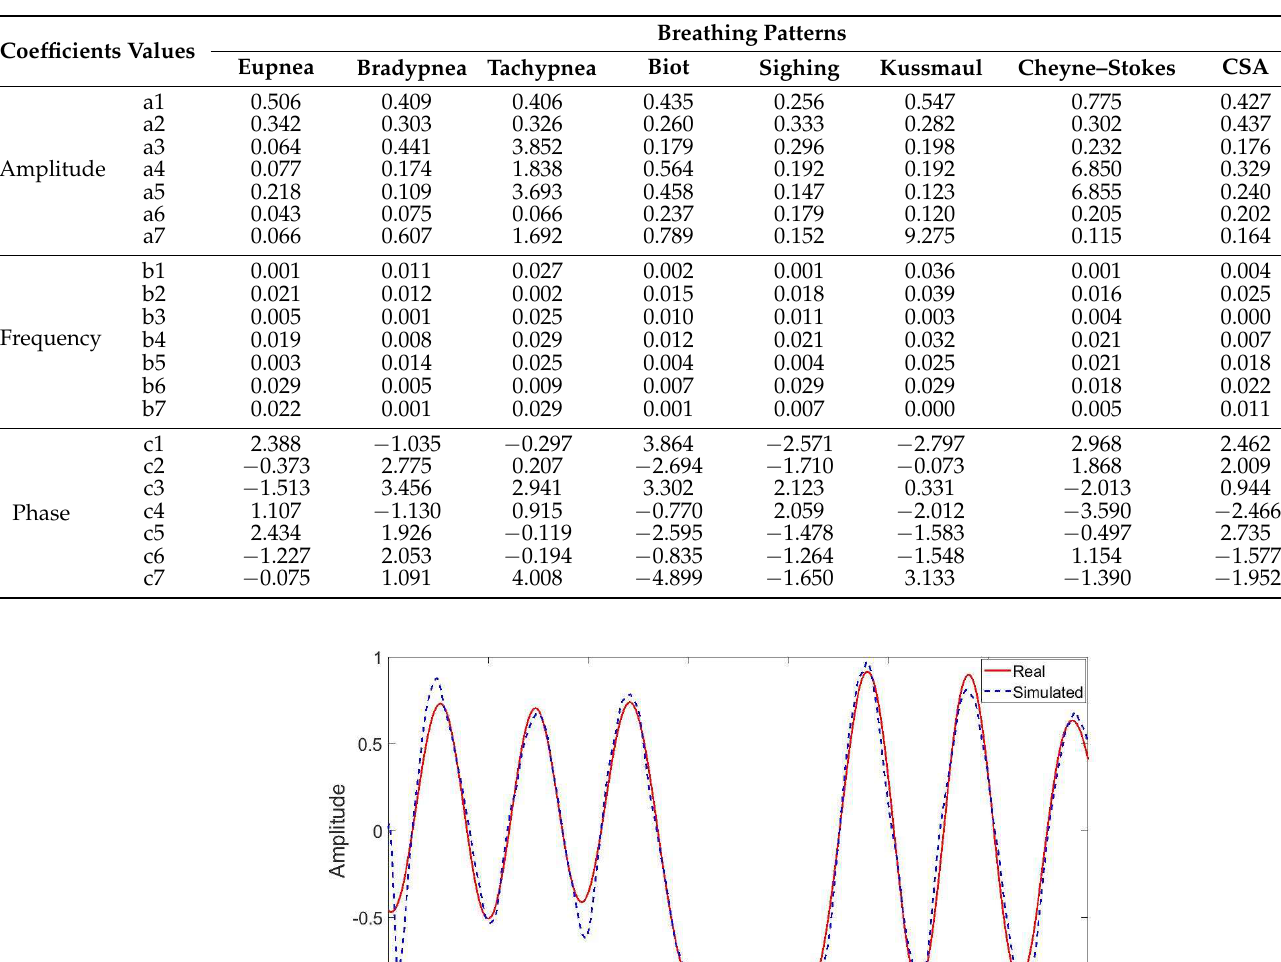
Table 1. Coefficients values for simulated breathing patterns.